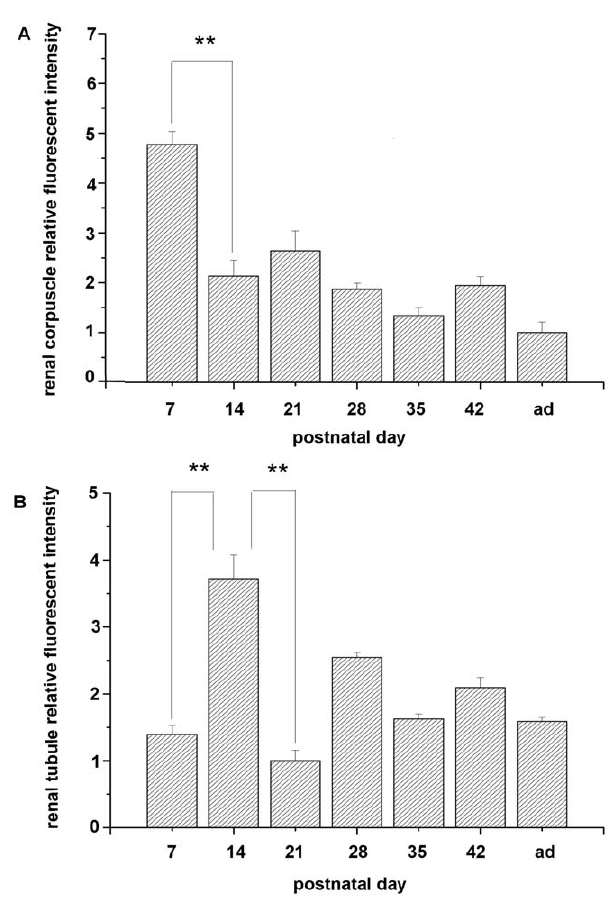
Figure 2. Relative fluorescent intensity of renal corpuscle part (A) and renal tubule part (B).